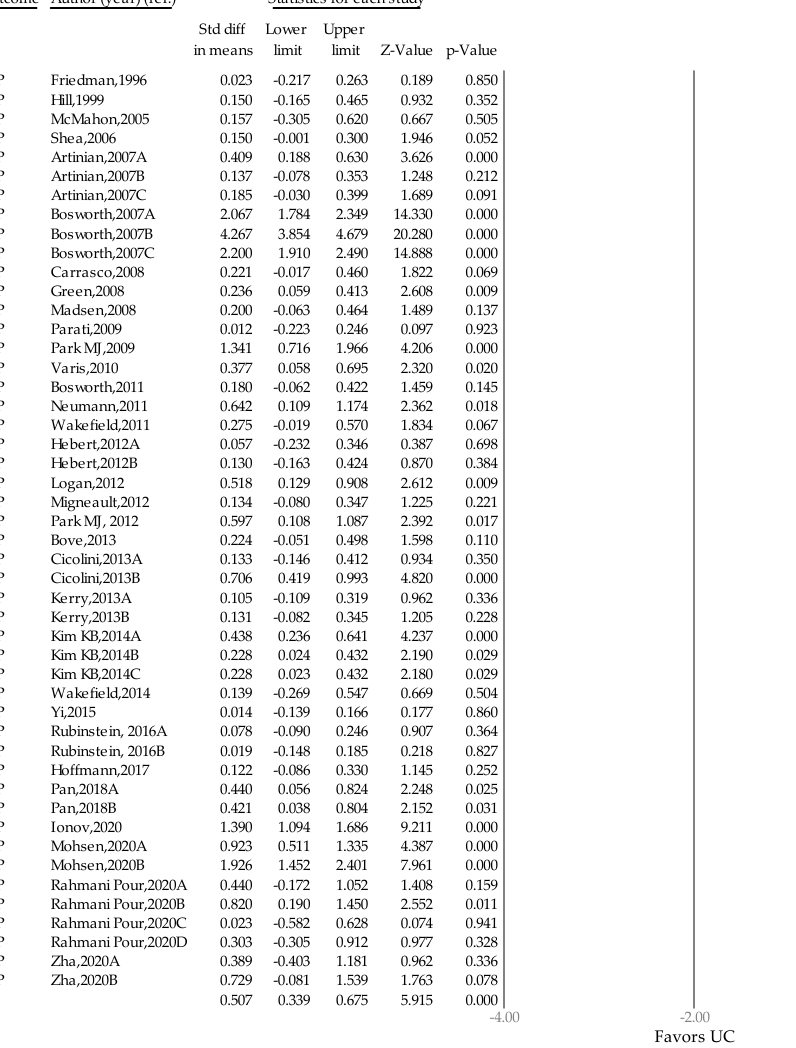
Figure 3. A funnel plot of standardized mean difference in diastolic blood pressure. Note: summary effect size ( ◇ ), sum- mary effect size of imputed studies ( ◆ ), individual study ( ○